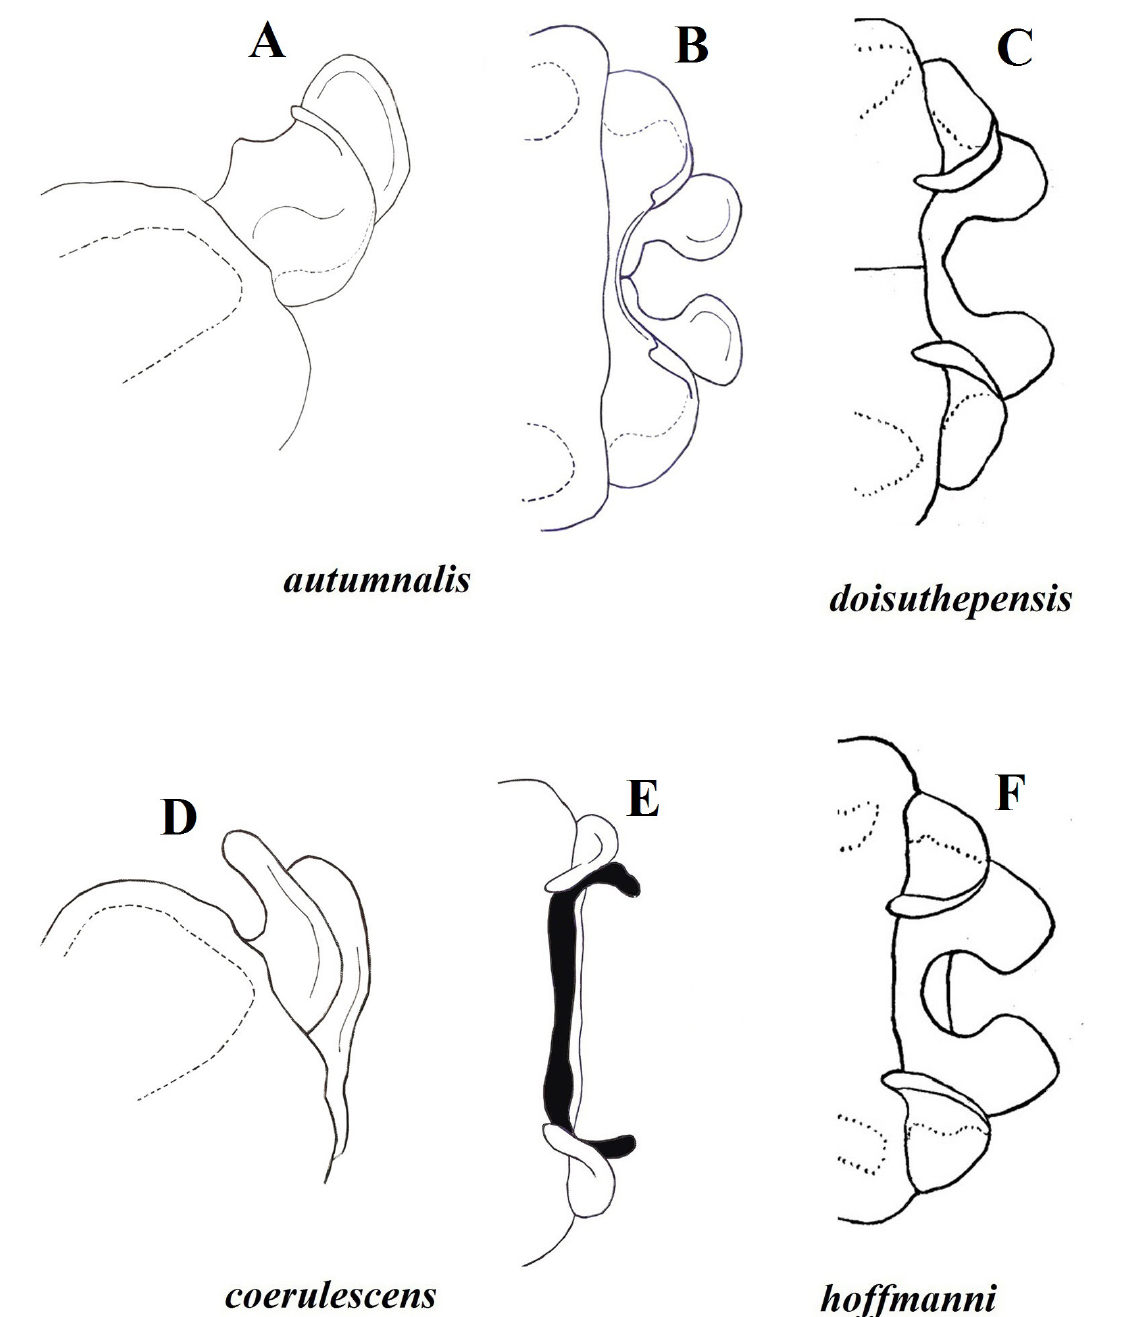
Fig. 5. Posterior pronotal lobe of prothorax of Prodasineura Cowley, 1934 spp., females. A–B . P. autumnalis (Fraser, 1922), lateral and dorsal views. C . P. doisuthepensis Hoess, 2007, dorsal view. D–E . P. coerulescens (Fraser, 1932), lateral and dorsal views. F . P. hoffmanni Kosterin, 2015, dorsal view. (Fig. 5C, F is modified from Kosterin 2015: fig. 3c–d). Images not to